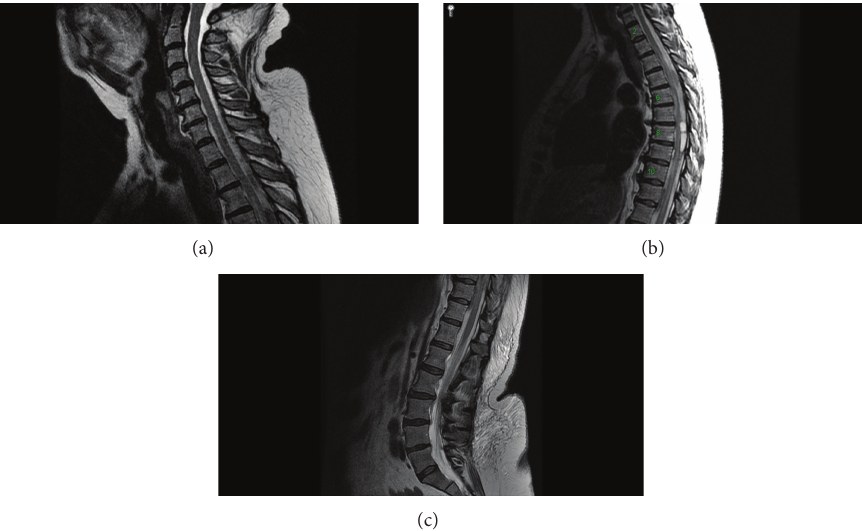
Figure 1: Sagittal T2 MR images of the cervical (a), thoracic (b), and lumbar (c) spine showing a complex cystic lesion in the dorsal spinal canal, spanning from above T1 to below T11, with spinal cord compression. Additionally, there is mildly increased T2 signal centrally within the spinal cord from the T3 to T11